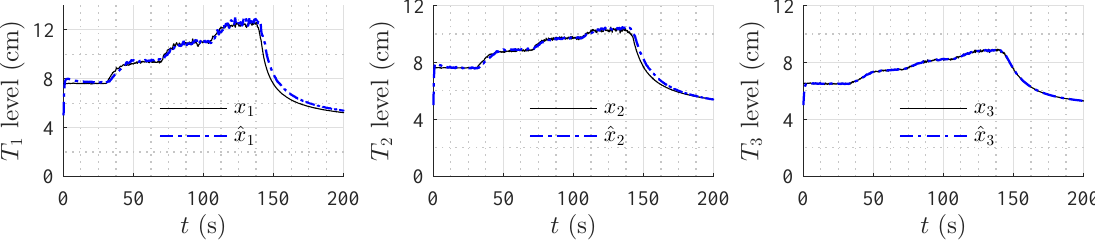
Figure 9. HGO experimental results: rectangular weir at T 2 and linear weir at T 3 , k = [ 0.8,0.17,0.01 ] T .